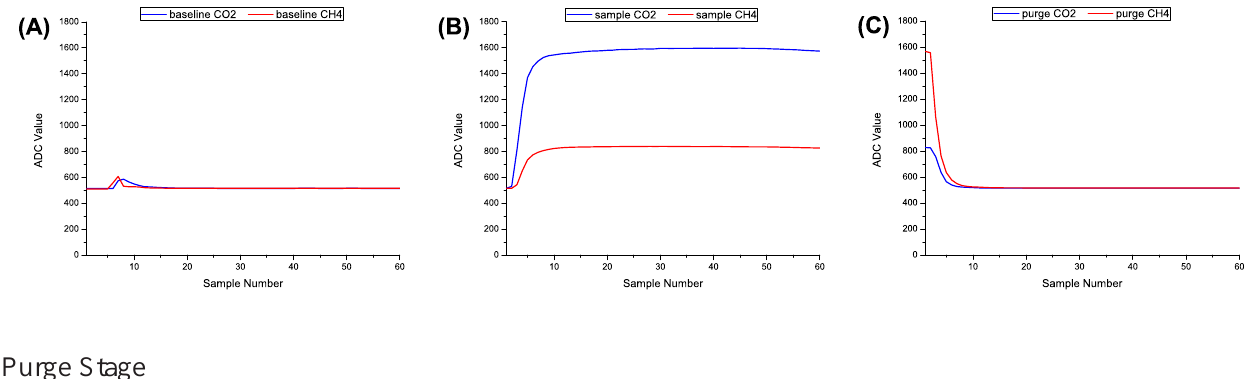
Figure 12. Profile of a typical 9 minutes baseline (A), sample (B), & purge (C) sampling stage, which is comprised of 180 CO 2 & CH 4 samples recorded every 3 seconds. This occurs in the order of 60 × baseline , 60 × sample , and 60 × purge samples. Initially all 180 items were sampled, however after a close analysis of 10+ weeks of data, we have been able to